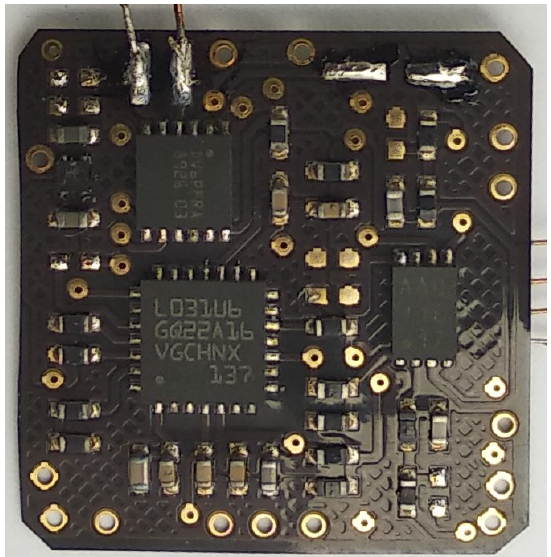
Figure 8. Photograph of one sensor node after a high temperature stability